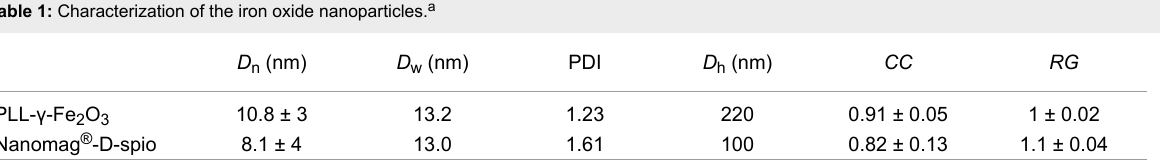
Table 1: Characterization of the iron oxide nanoparticles.